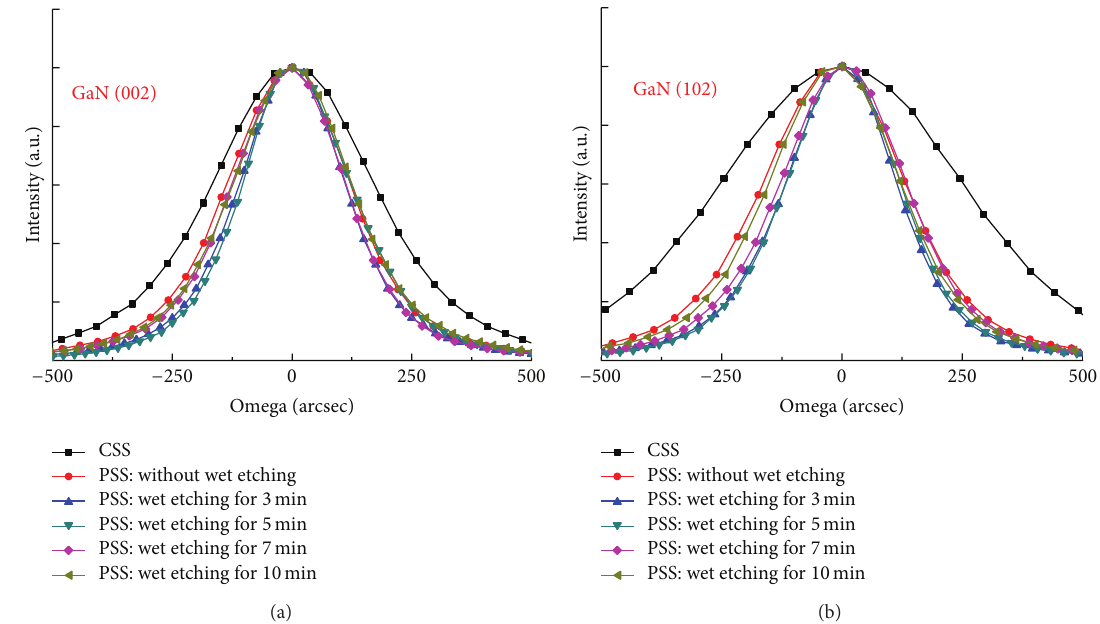
Figure 2: XRD FWHM values for the (a) (002) and (b) (102) reflections of GaN epilayers prepared on the CSS and various cone-shaped PSSs.